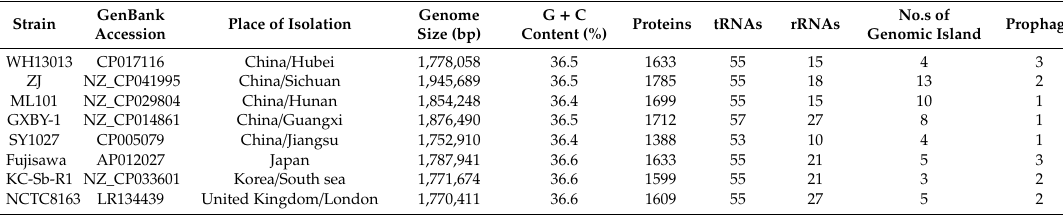
Table 1. General features of the WH13013 genome and the other E. rhusiopathiae genomes.